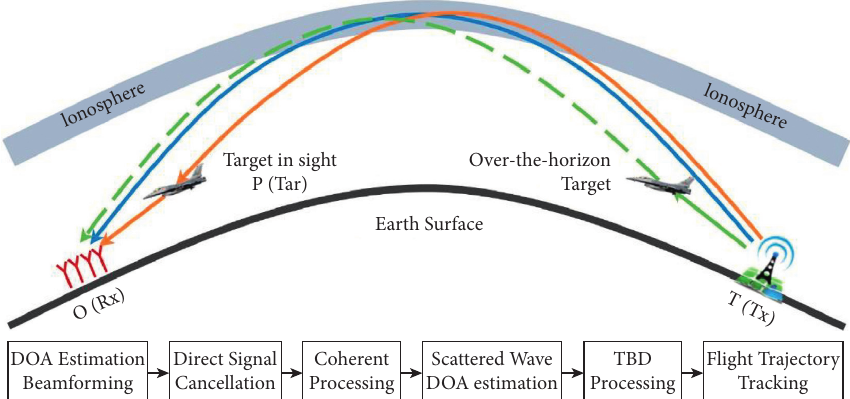
Figure 1: Illustration of operational concept and signal processing flowchart for AM radio-based passive radar.